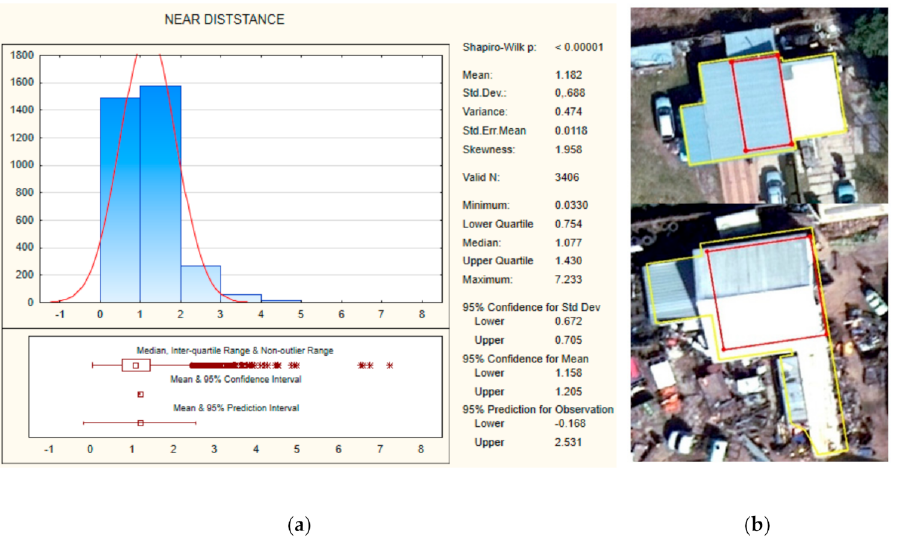
Figure 11. Differences between building outlines from remote sensing and cadastral data: ( a ) de- scriptive statistics, ( b ) analyzed cadastral buildings contained two outlines derived from LiDAR data processing (see an example in Figure 12a).